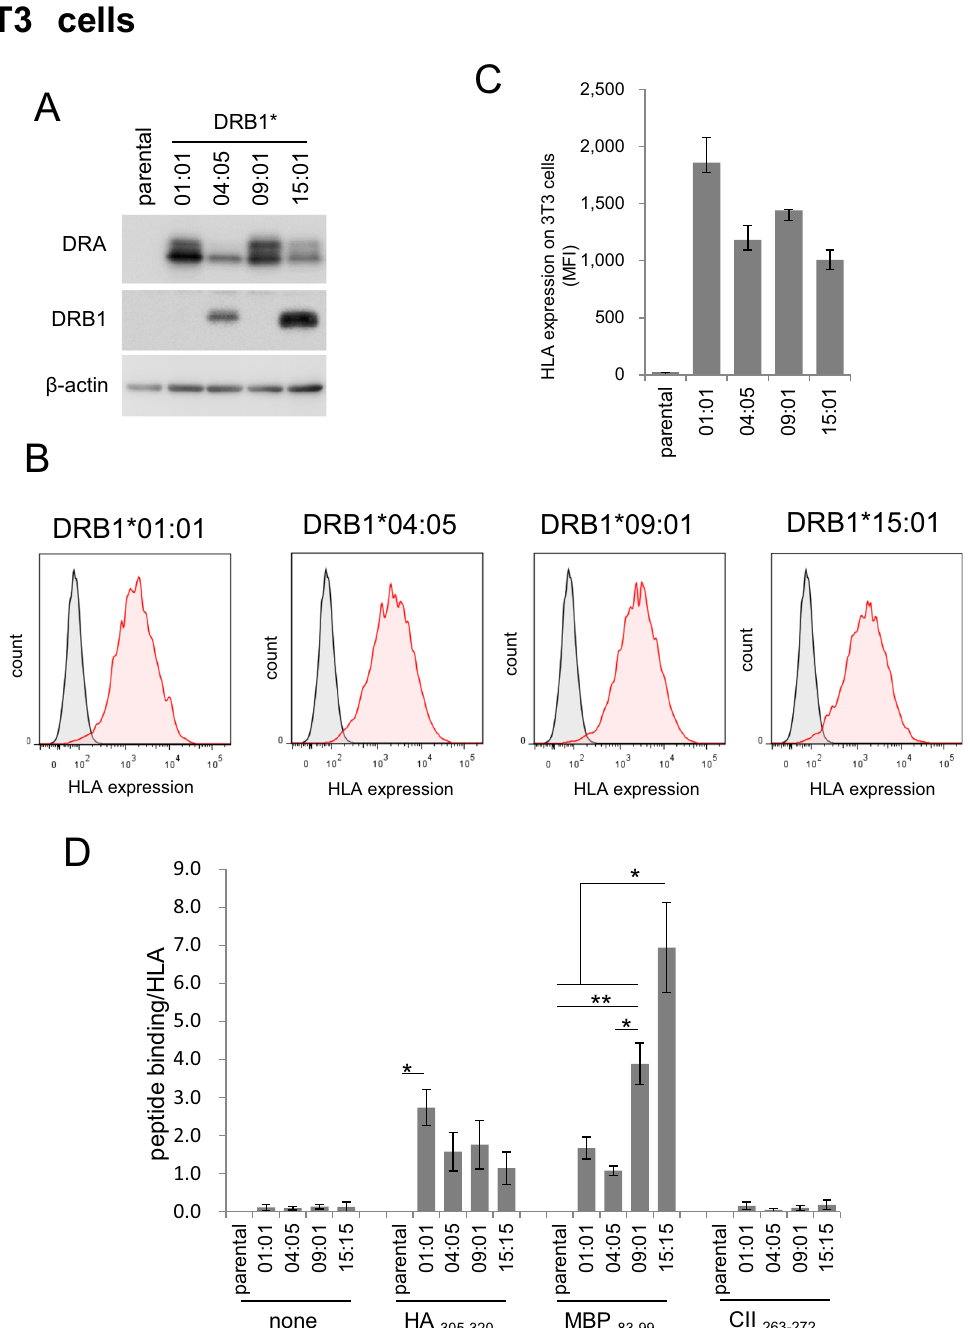
Figure 2. Stable expression of HLA molecules and binding to various antigen peptides in murine 3T3 cells. ( A ) Western blot analysis of HLA-DR expression levels in various HLA-expressing 3T3 cells. ( B,C ) FACS analysis of cell-surface expression of HLA-DR molecules in 3T3 cells. The grey peak and pink peak represent untransfected control cells and respective DRB1 transfected cells, respectively. The graph shown is a summary of the FACS results of two independent measurements and expressed as mean ± range ( C ). Western blotting and peptide binding assay were performed, and one representative result is shown. ( D ) Summary of the relative binding affinity of various HLA-DR and antigen peptides. Peptide binding assay was carried out in various HLA-expressing 3T3 cells (Supplementary Fig. 2). For each peptide group, peptide binding/HLA was calculated by subtracting the MFI value for the parental 3T3 cells from individual MFI. Then, the net MFI values were divided by the respective MFI value for HLA expression levels (Fig. 2C). The values are mean ± inter-assay deviation expressed as SEM of three independent experiments. Statistical significance is as follows: * P < 0.05 and ** P <